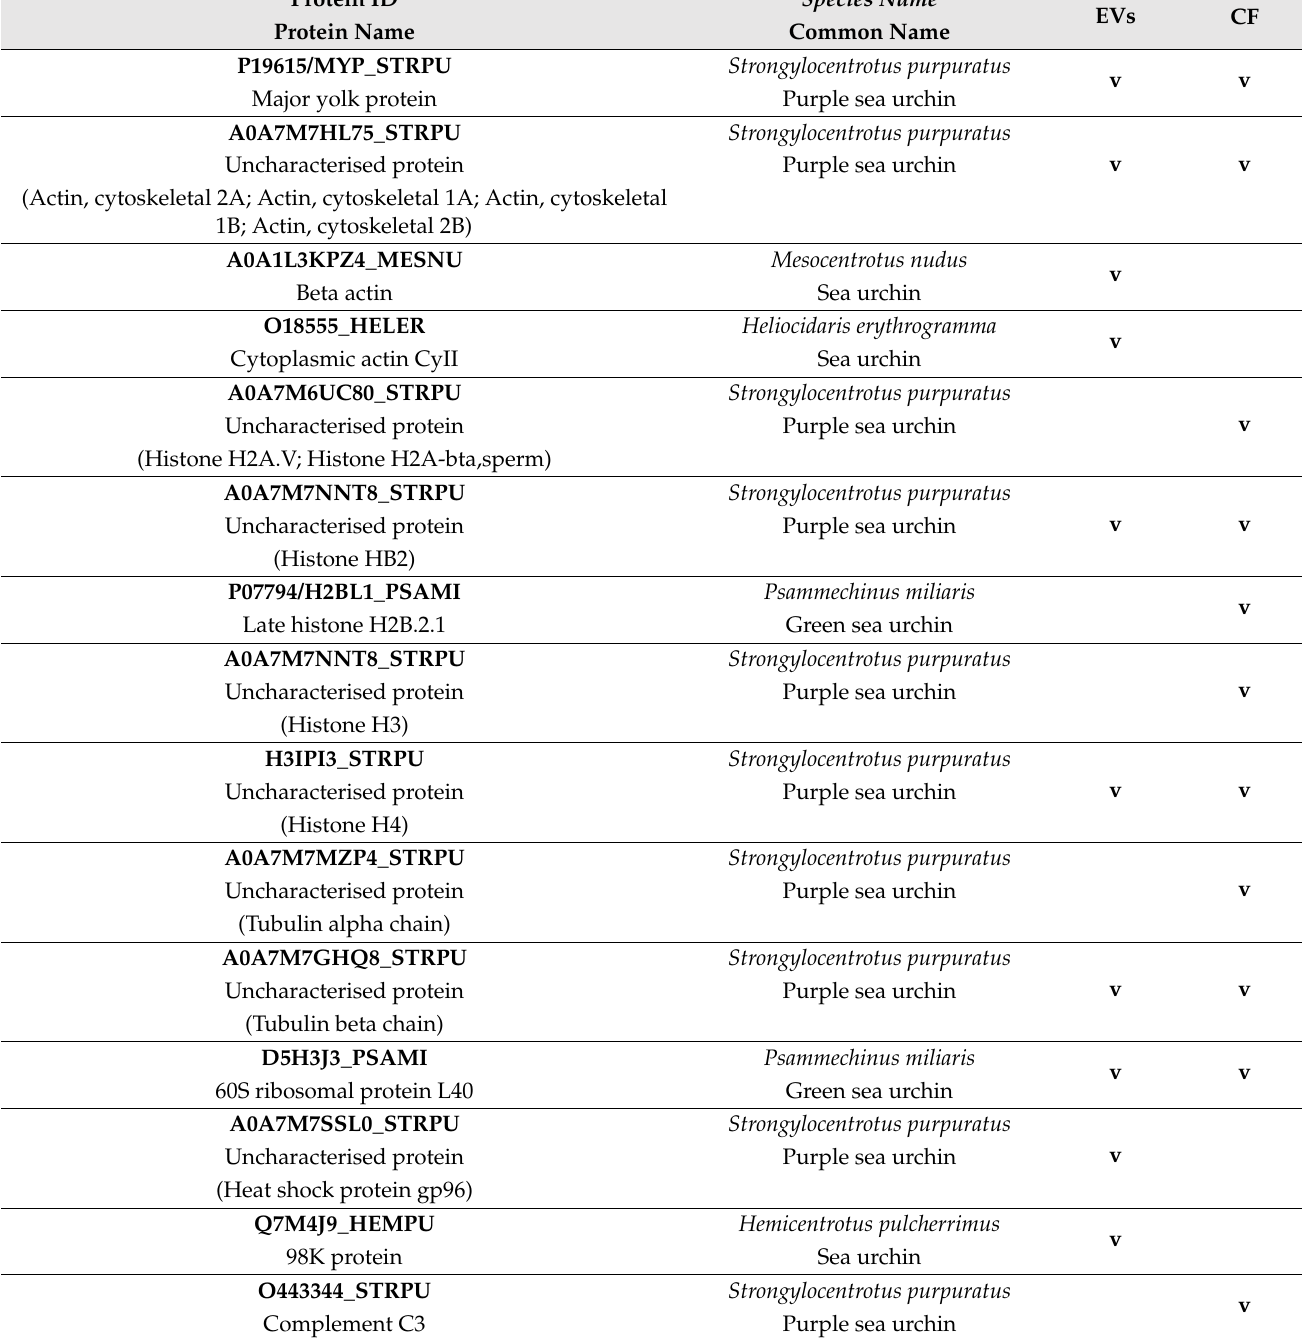
Table 2. Deiminated proteins identified by F95 enrichment and liquid chromatography with tandem mass spectrometry (LC-MS/MS) analysis in coelomic fluid (CF; pool of 3 individual samples) and EVs (pool of 3 individual samples) of purple sea urchin ( Strongylocentrotus purpuratus ); hits are run against the UniProt Echinoidea database. Proteins identified as deimination hits in EVs, coelomic fluid (CF), or both are indicated by a tick (v) for the columns representing EVs and CF, respectively. Uncharacterised hits with an annotated secondary hit are included and indicated in brackets; other unidentified protein hits are not included in this table. Further detailed analysis on number of matches and total score is provided in Supplementary Tables S2 and S3, respectively, as well as full LC-MS/MS results (also including data from a common contaminant database; cRAP 20,190,401; 125 sequences; 41,129 residues) in Supplementary Tables S4 and S5,